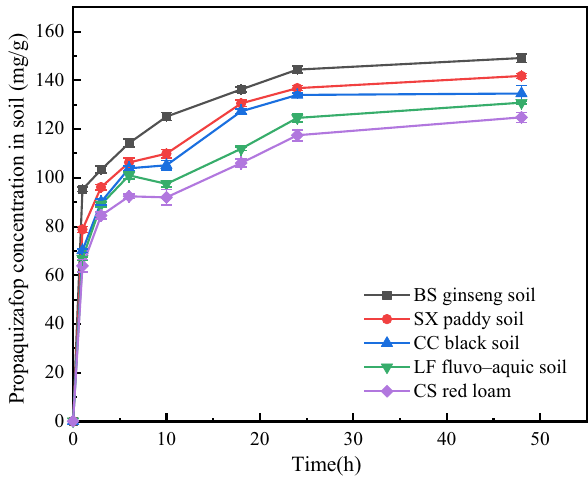
Figure 2. Adsorption kinetics of propaquizafop in different soil types (n =